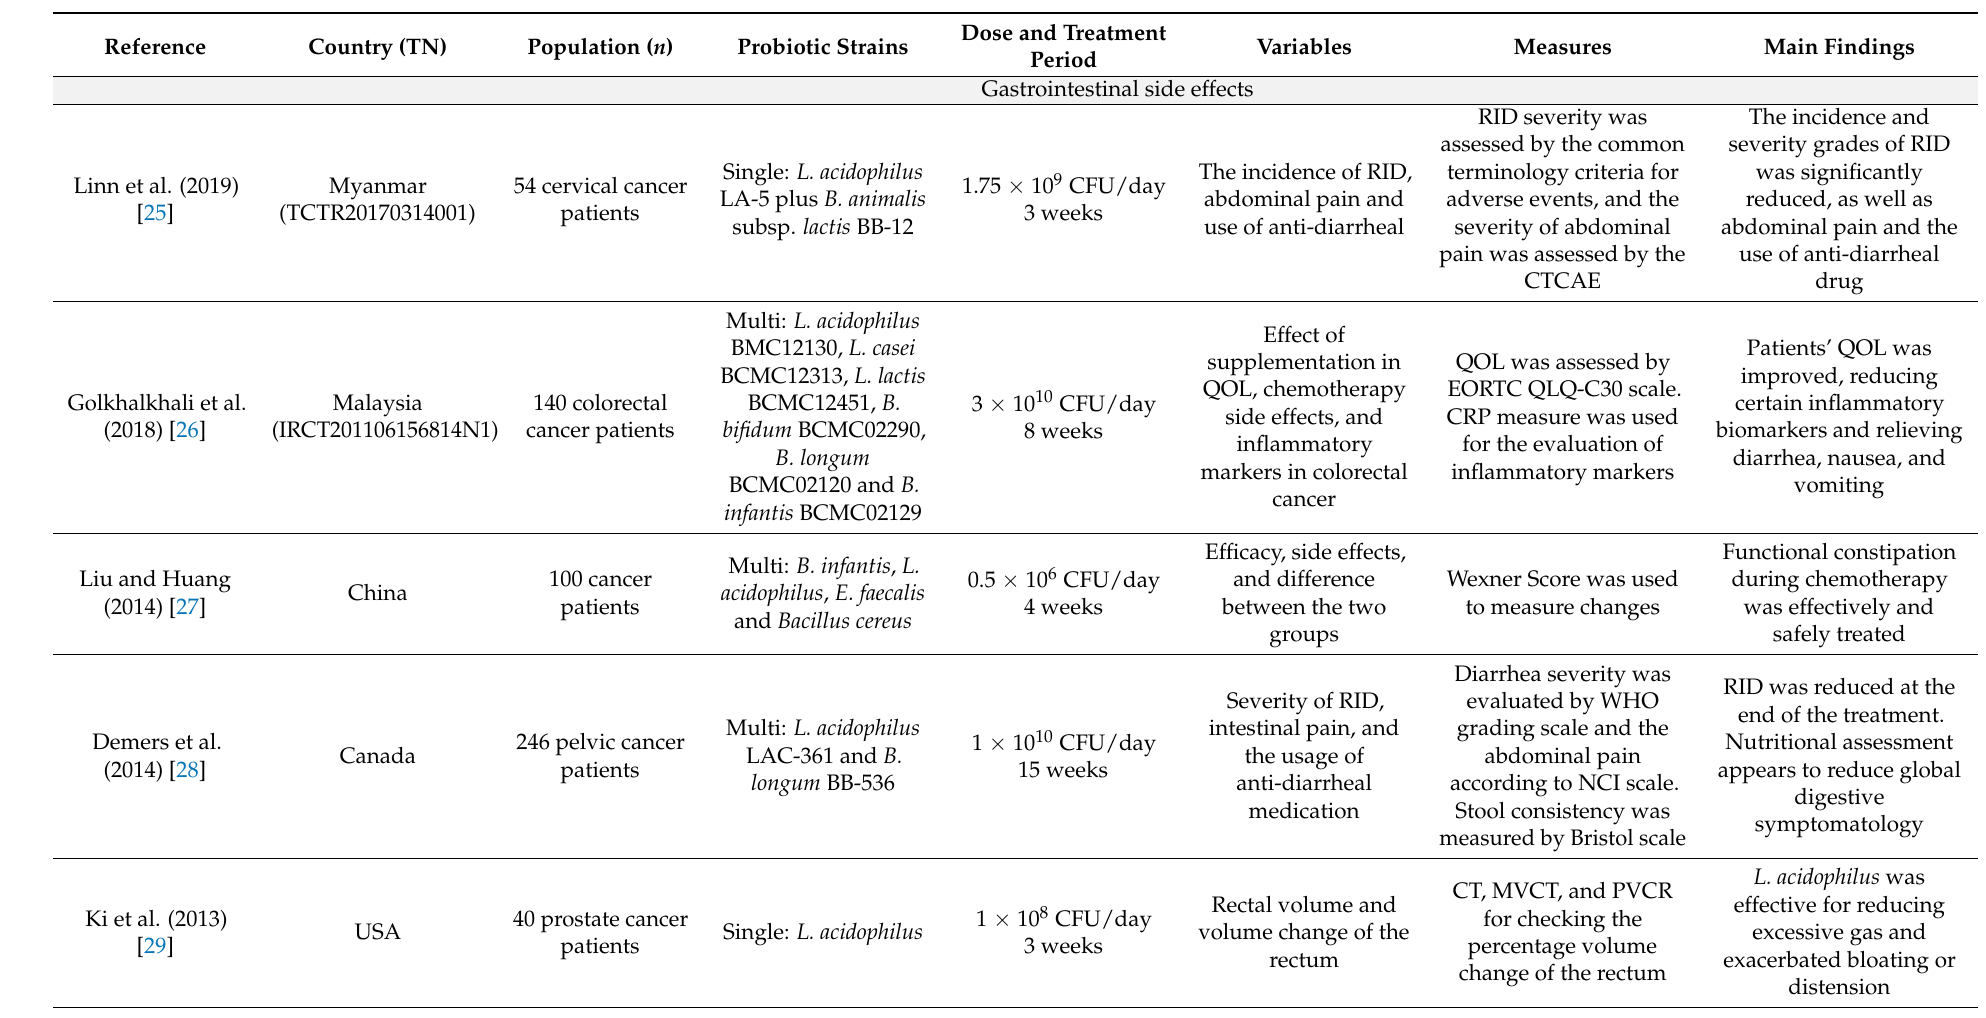
Table 1. Overview of clinical selected